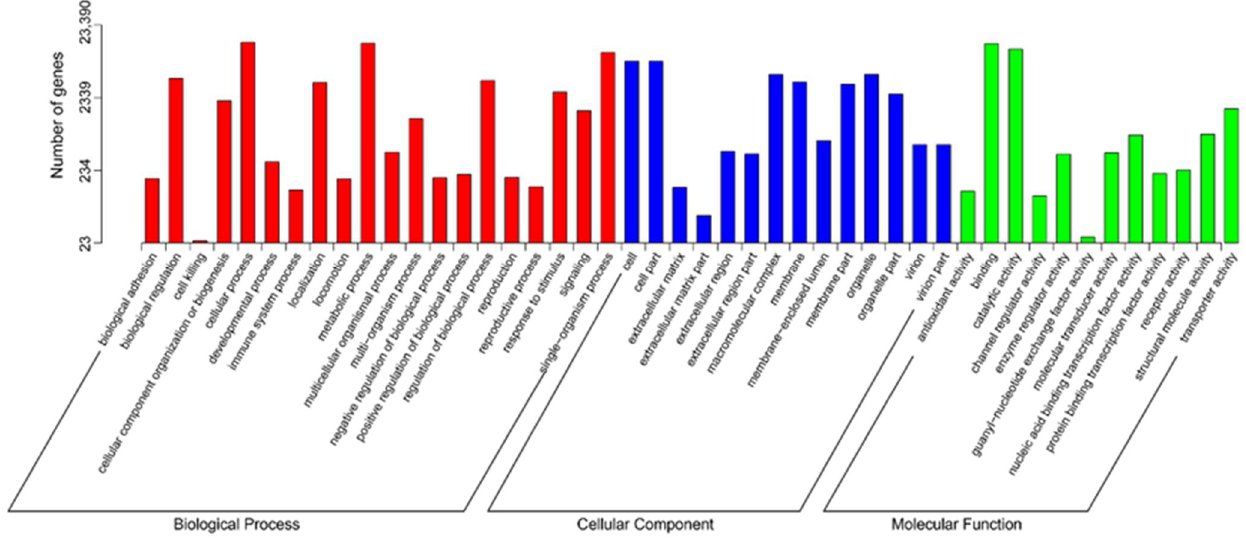
Figure 2. GO classification of assembled unigenes of the L. yunnanensis flower transcriptome. The x -axis indicates the subgroups in GO annotation; the y -axis indicates the number of genes in each category.